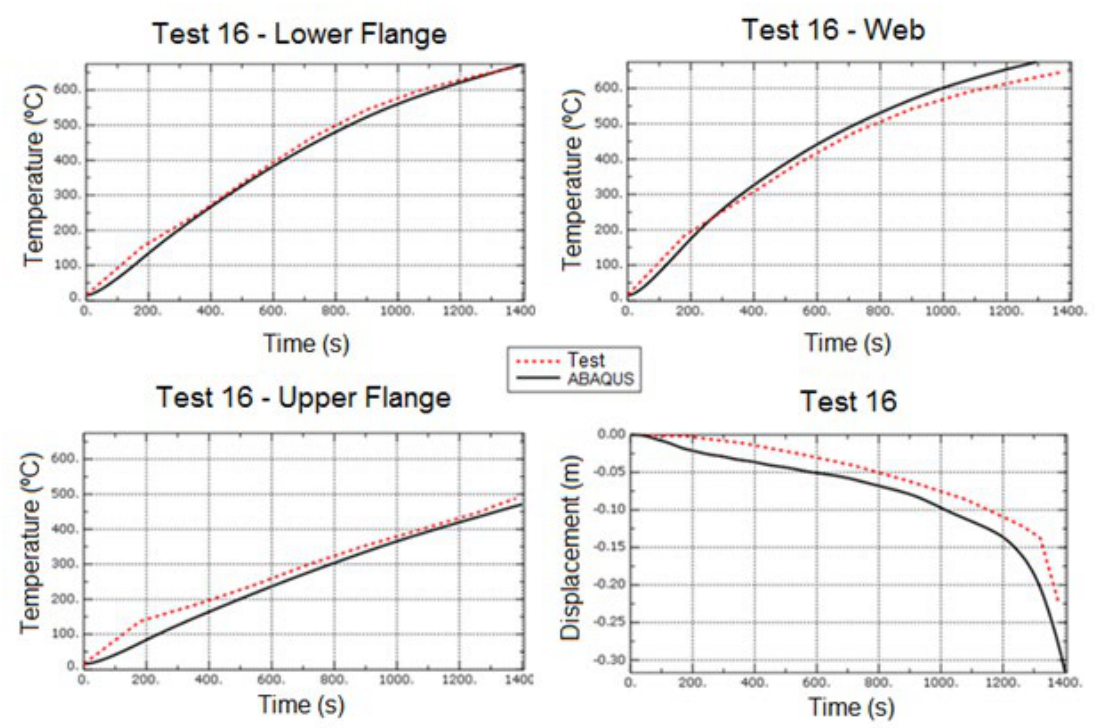
Figure 10. Numerical model compared to Test 16